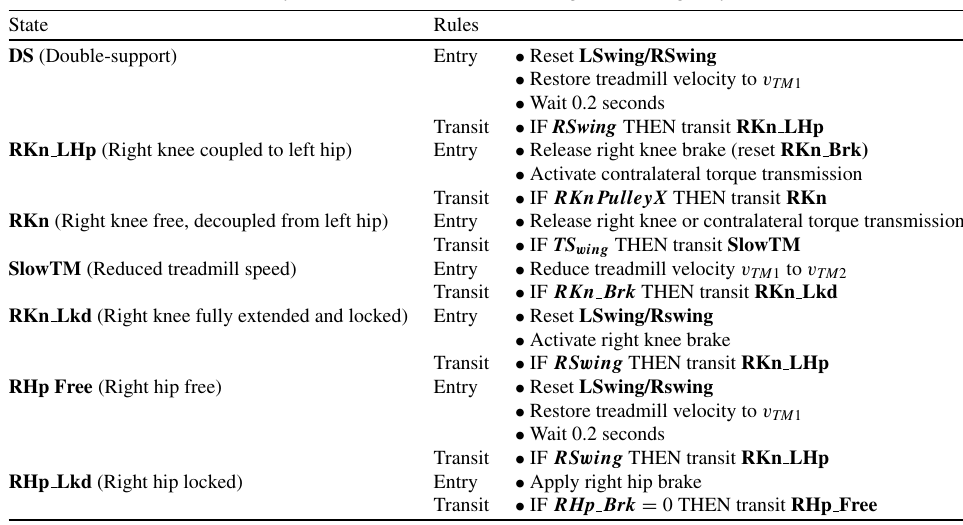
Table 1 Summary of states and transition rules during 50% of the gait